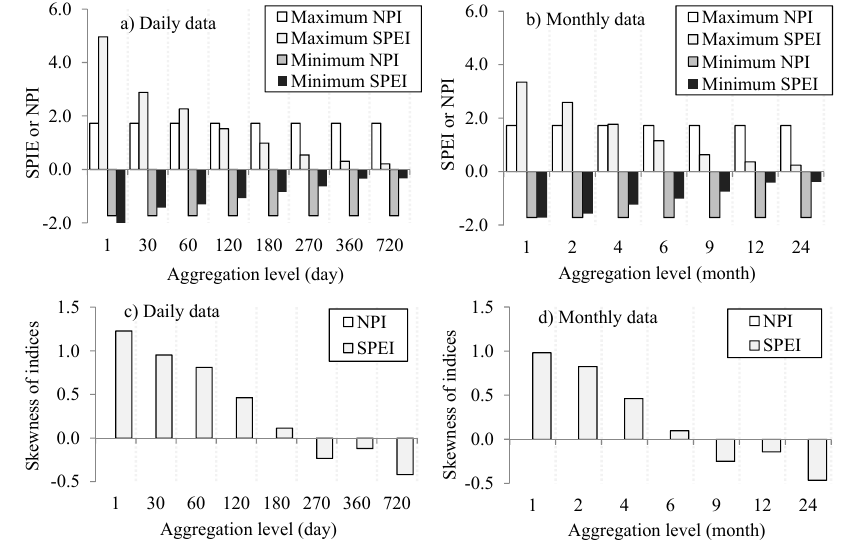
Figure 12. Extreme dry and wet conditions in terms of NPI and SPEI based on catchment-wide: ( a ) daily; and ( b ) monthly precipitation insufficiency over the period 1979–2002; and ( c , d ) the skewness of the indices based on daily and monthly precipitation insufficiency, respectively.